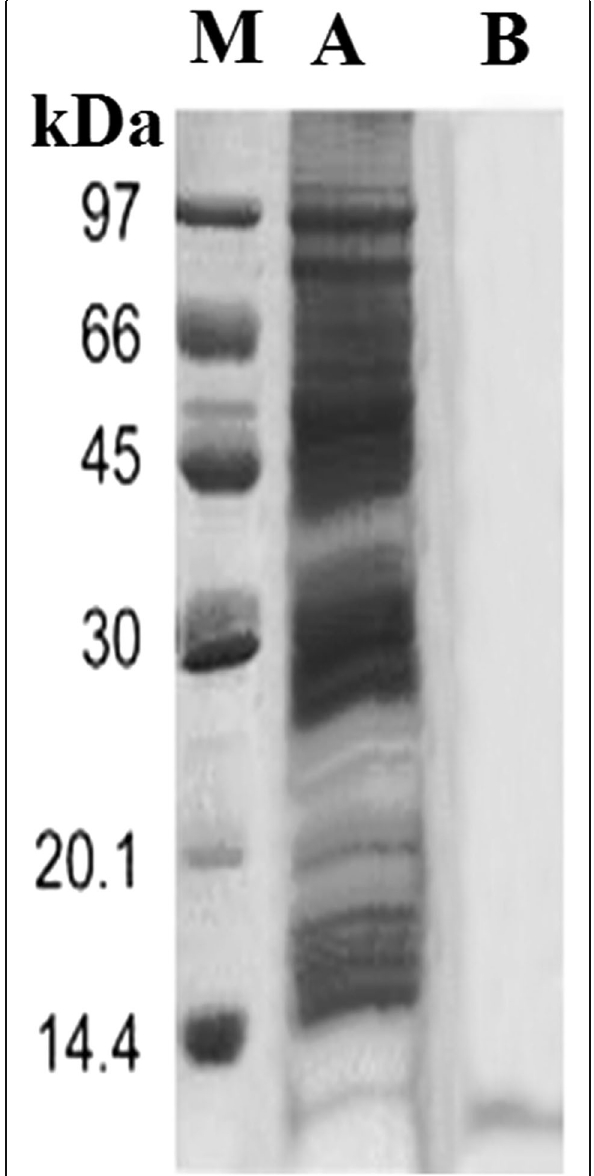
Fig. 1 Separation and purification of defensin peptide from Trigonella foenum-graecum seeds. A 10% ( v / v ) SDS- polyacrylamide gel was loaded with protein extracts from seeds (lane A = total protein, lane B = purified fraction after elution on sepharose column. M illustrates the protein marker with band sizes shown in kDa. The gel was stained with Coomassie Brilliant Blue